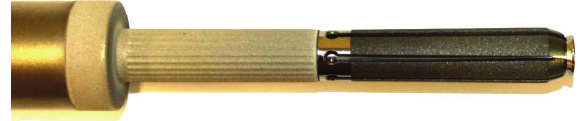
Figure 1: Tip of the spreading stem.